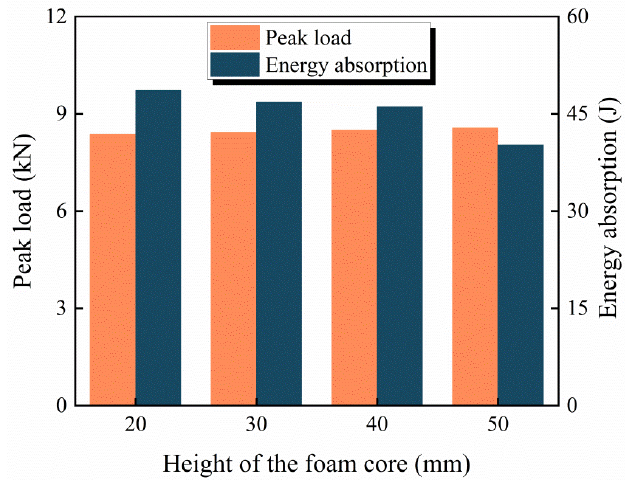
Figure 14. Peak load and impact energy absorption with different foam core heights.